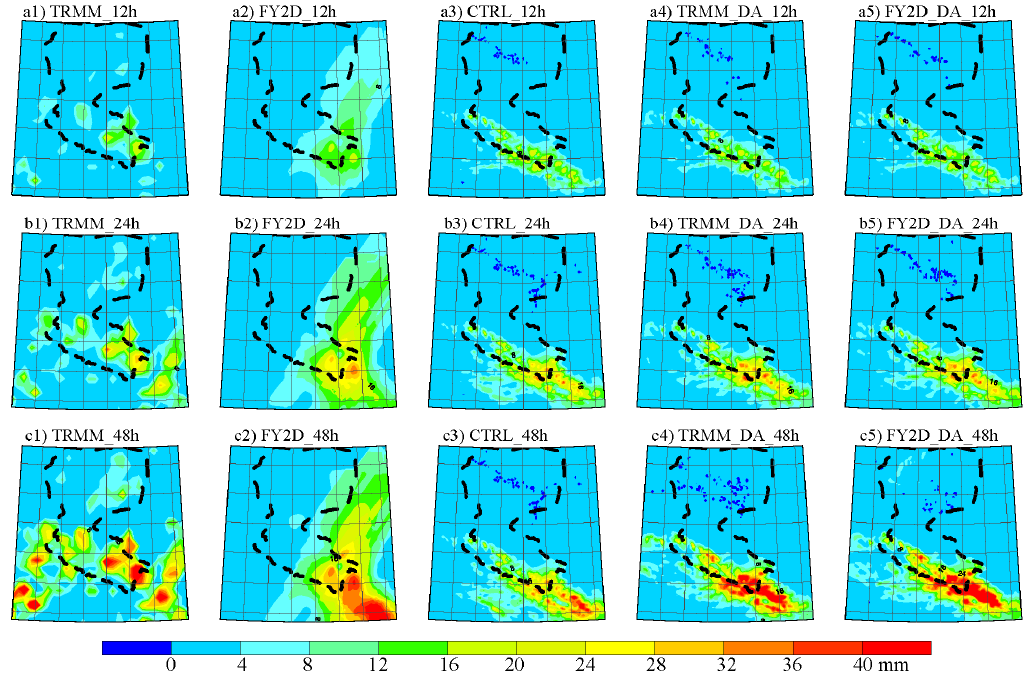
Figure 8. Accumulated precipitation at 12 h, 24 h, and 48 h from 21 to 23 June 2008 (the assimilation window is from 00:00 UTC to 06:00 UTC, 21 June 2008): (a1)/(b1)/(c1) for TRMM 3B42 V6 remote sensing products; (a2)/(b2)/(c2) for FY-2D remote sensing products; 3) (a3)/(b3)/(c3) for control simulation; (a4)/(b4)/(c4) for TRMM assimilation; (a5)/(b5)/(c5) for FY assimilation.